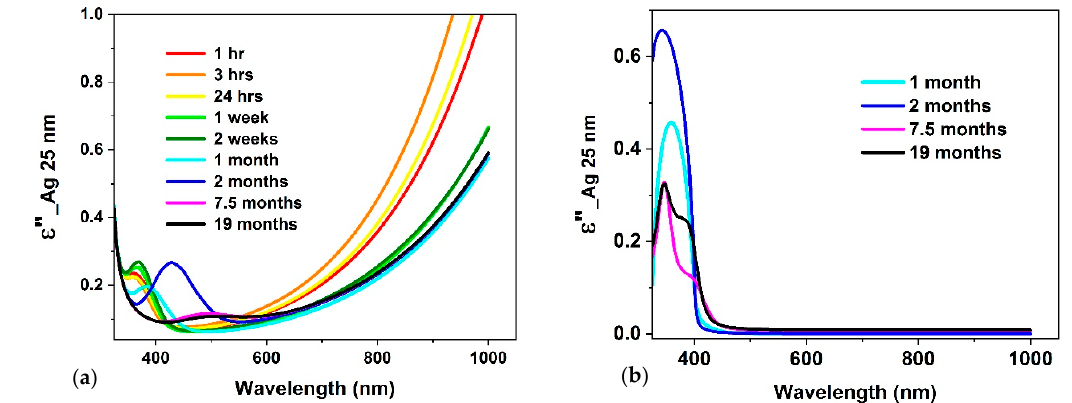
Figure 8. Dielectric permittivity imaginary part evolution for the 25 nm Ag thin films: ( a ) main layer; ( b ) roughness layer in the range of 330–1000 nm.